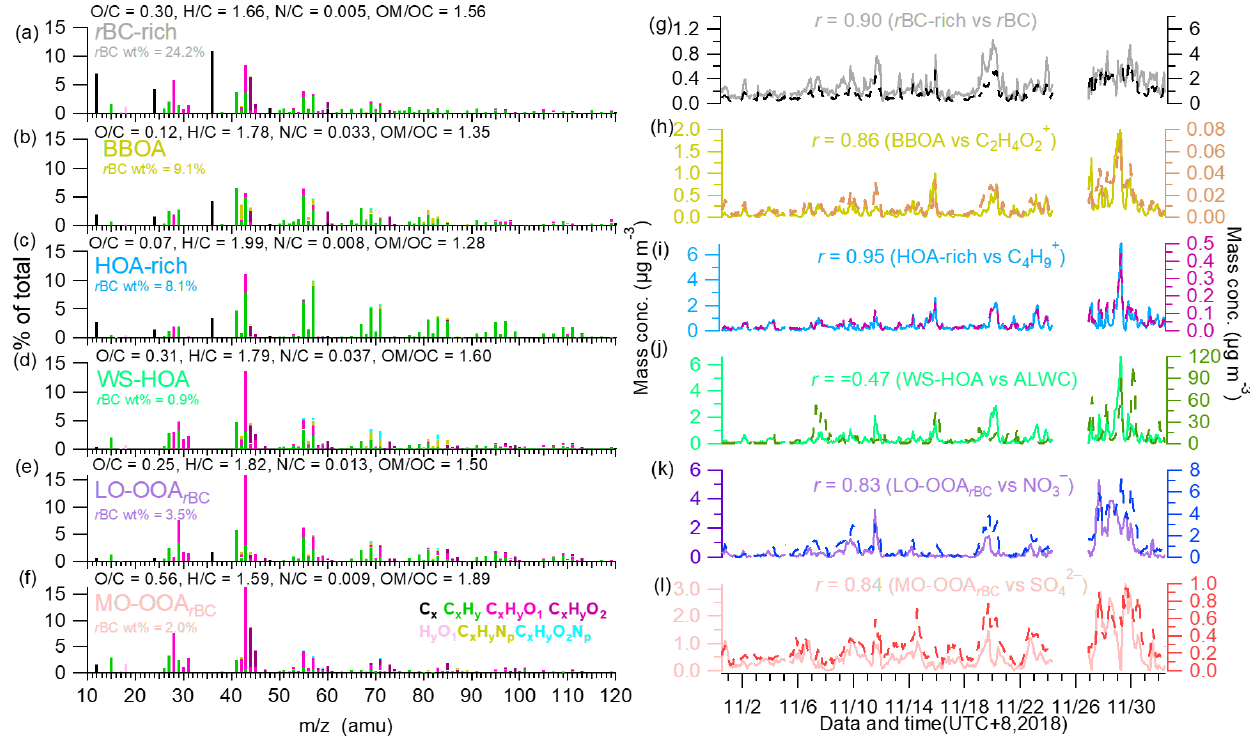
Figure 3. High-resolution mass spectra of the (a) rBC-rich factor, (b) BBOA, (c) HOA-rich factor, (d) WS-HOA, (e) LO-OOA rBC and (f) MO-OOA rBC . (g–l) Time series of the corresponding factors, their tracers (rBC, C 2 H 4 O), C 4 H + 9, ALWC, nitrate and sulfate), as well as the correlation coefficients. ALWC refers to the aerosol liquid water content, which was estimated using Extended Aerosol Inorganic Model II (E-AIM II); Clegg et al., 1998). Calculation details and results for different RH values are described in the caption and shown in Fig.